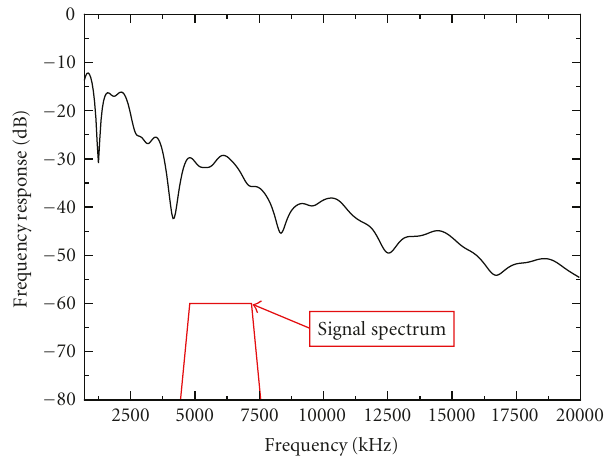
in (25) for (cid:8) = 1